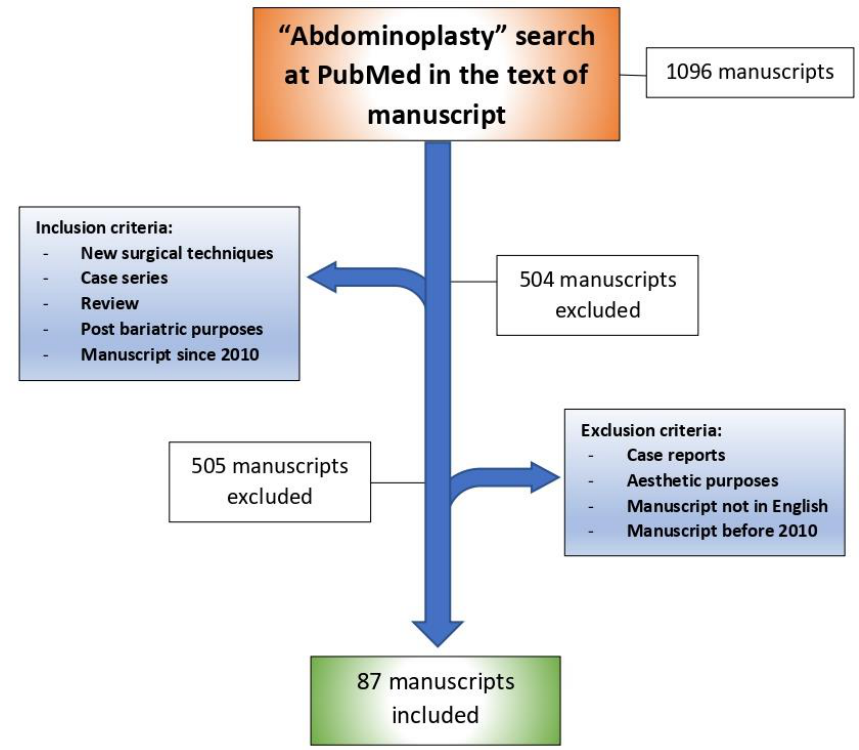
Figure 4. Searching process flow chart displaying inclusion and exclusion criteria.